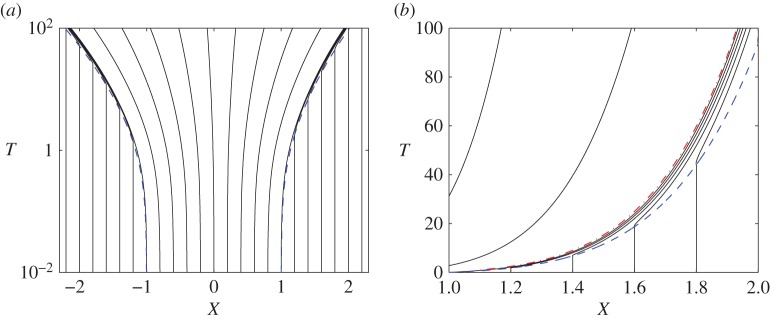
(a) Contact-line locations X=a±(T) (dashed) and characteristics (solid) calculated from dX/dT=U¯ for the flow presented in figure 2, using U¯=U¯com. (b) Near the right-hand contact line, characteristics cross X=a+(T) and accumulate in a narrow region behind it. The dotted-dashed line indicates the characteristic along which U¯X=0, lying in the overlap between the inner and outer regions. T is plotted on a log scale in (a) and a linear scale in (b). (Online version in colour.)